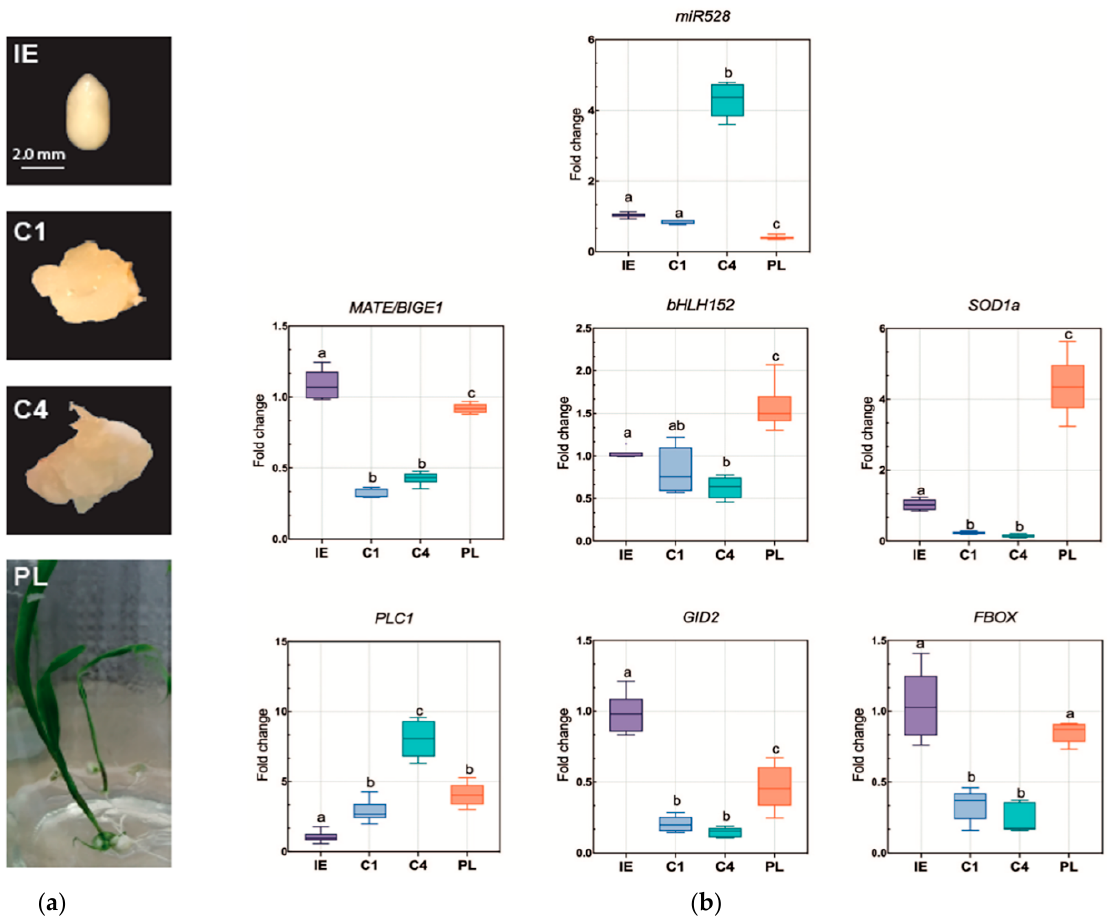
Figure 3. zma-miR528 and mRNA target accumulation levels in VS-535 SE. ( a ) Different tissue samples obtained from maize SE stages used for miRNA and target profiling. Immature embryos (IE) at 15–18 days after pollination (DAP) used as initial explant for SE initiation. One month after induction, friable embryogenic callus (C1) was selected for sampling. Embryogenic calli were subcultured monthly, and proliferation was established after four months (C4). By gradual hormone reduction and photoperiod exposure, plantlet (PL) regeneration was achieved. ( b ) zma-miR528 and selected target levels were analyzed by RT-qPCR in total RNA from the samples mentioned above. Fold change represents abundance relative to IE and normalized either by U6 snRNA internal control (microRNA) or 18S rRNA (transcripts). The results were obtained from three independent biological replicates ( n = 3) with three technical replicates for each one ( n = 9). Data were analyzed by performing a one-way ANOVA with multiple comparisons by the Tukey post hoc test. Boxes that do not share at least an identical letter differ significantly ( p < 0.005) from each other.